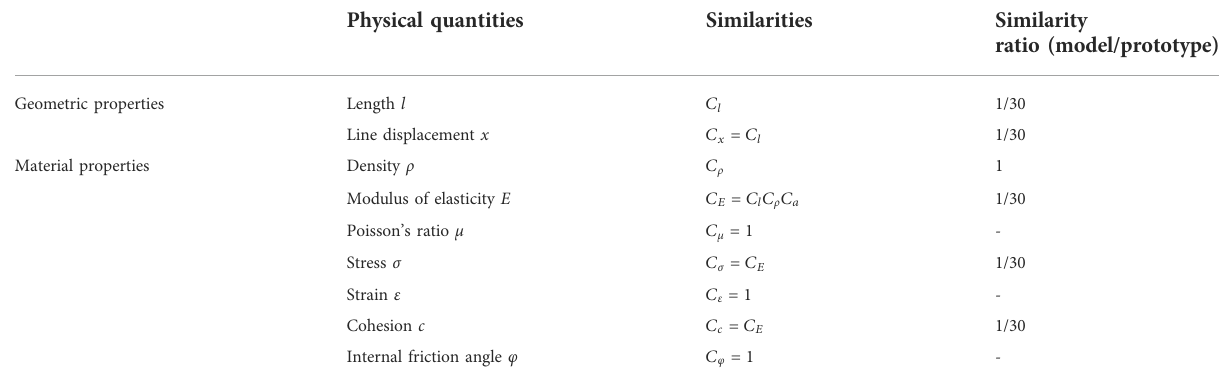
TABLE 2 Similarity